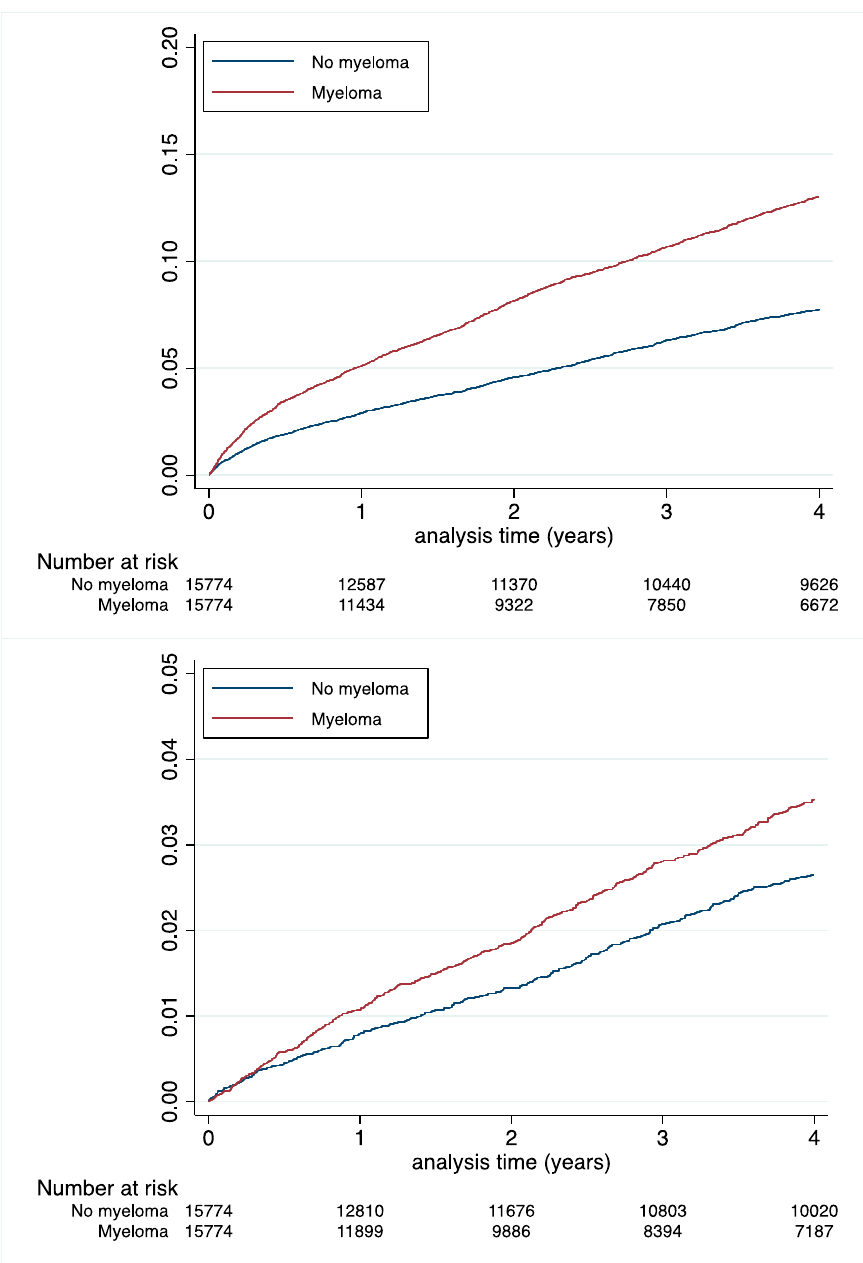
Figure 4. Cumulative incidences of major bleeding ( top panel) and intracranial bleeding ( lower panel) in the matched population.